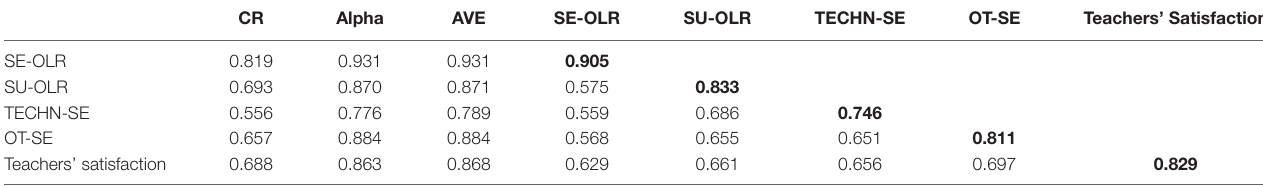
TABLE 4 | Measurement model results (Group 1, n = 895).